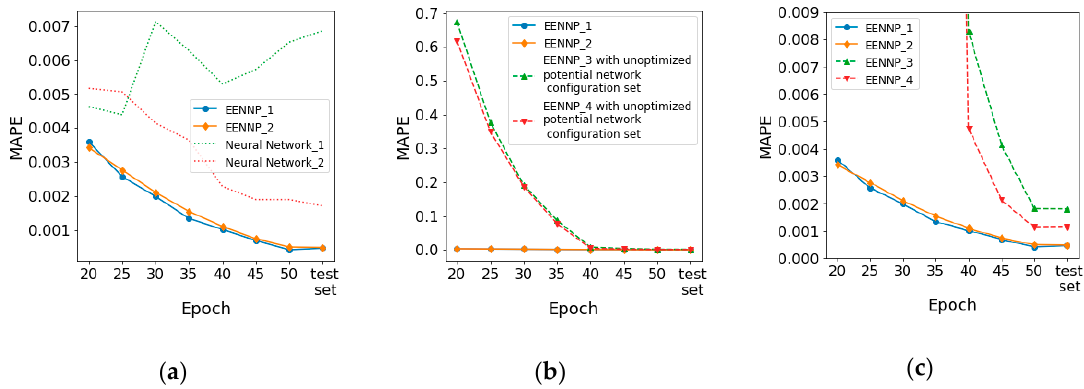
Figure 7. The performance of EENNP methods using different potential network configuration set: ( a ) The performance of two runs of EENNPs with the optimized potential network configuration set and two networks within the final survival population; ( b ) The performance of four runs of EENNPs in which two uses the optimized potential network configuration set and the other two uses the unoptimized set; ( c ) The comparation between the four EENNPs in detail.